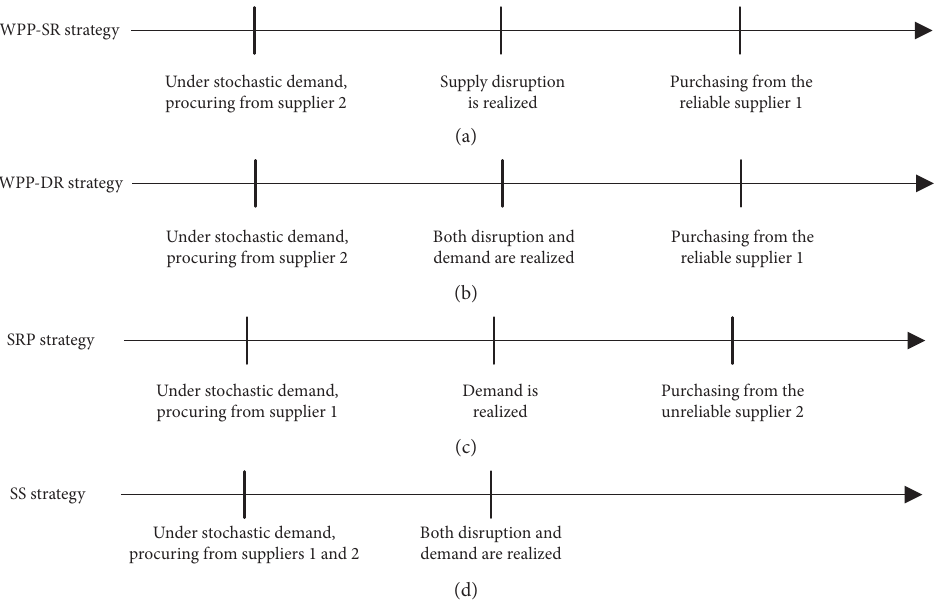
Figure 1: Retailer’s order sequences under different backup and simultaneous sourcing